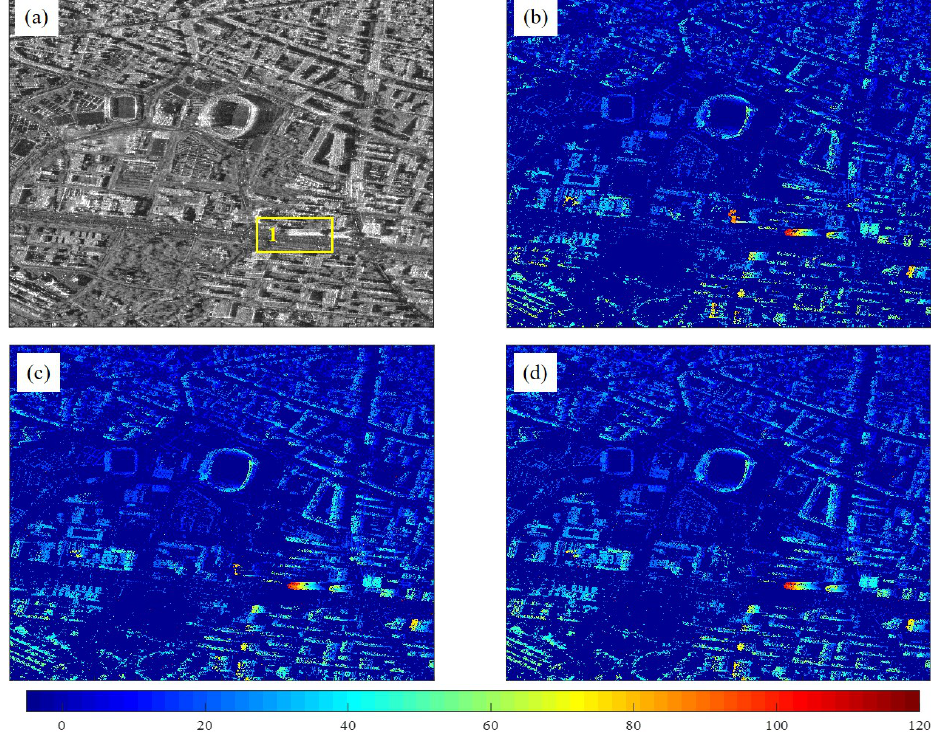
Figure 10. The estimated heights of the test area: ( a ) the corresponding SAR intensity; the estimated heights after PE compensation using the ( b ) TTNC, ( c ) NC-PGA and ( d ) BBN-PGA methods. A height model can be simulated to evaluate the accuracy of height